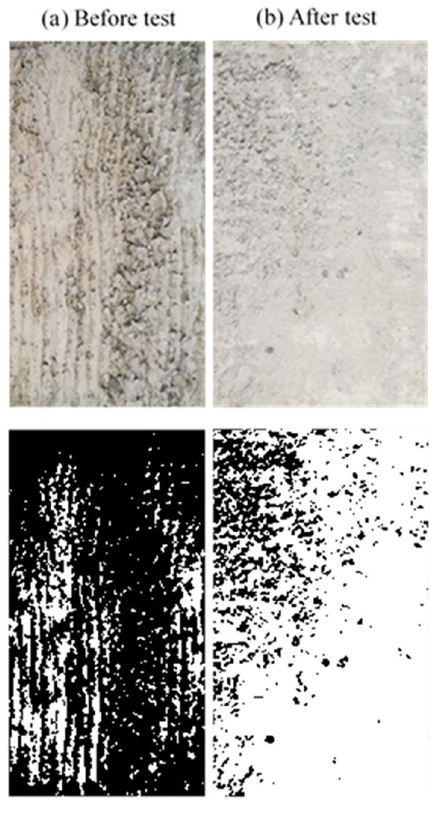
Figure 7. Rough surface before and after test.